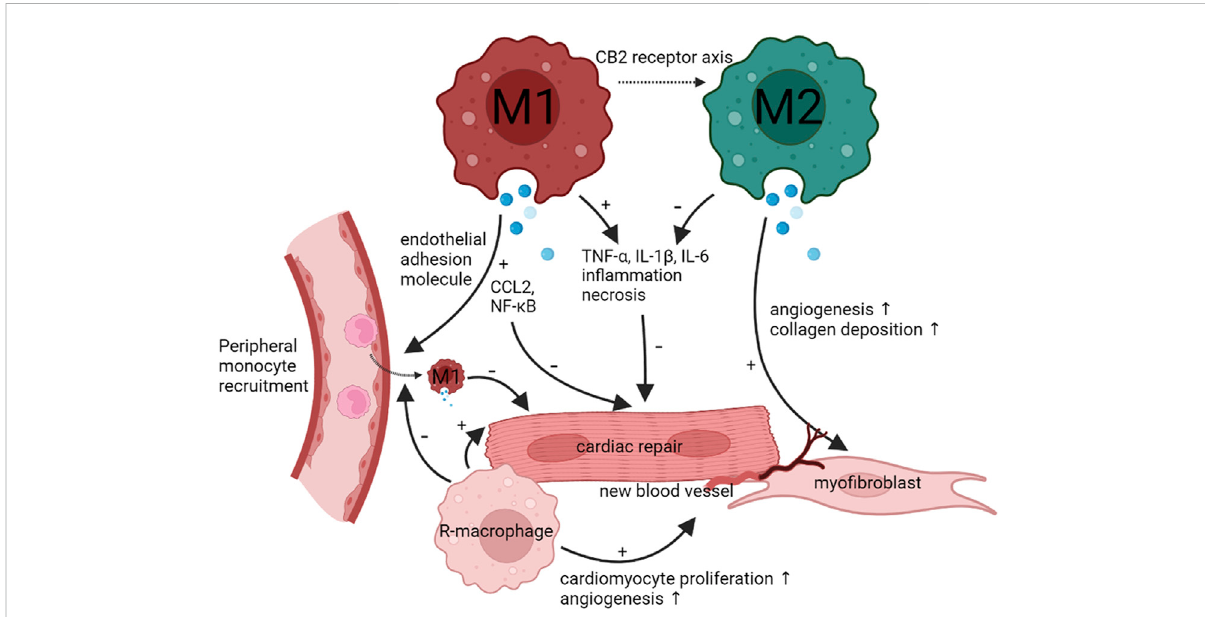
FIGURE 2 Functions and phenotype of macrophages during infection andtissue repair.When cardiomyocytes undergo injury, theheartrecruit peripheral monocyte to differentiate M1 macrophages. M1 macrophages will activate CCL2 and NF- κ B and promote TNF- α , IL-1 β , and IL-6 to inhibit cardiac repair and aggravate cardiomyocytes necrosis. As time goes on, M1 macrophages can transform M2 macrophages through CB2 receptor axis. M2 macrophages can inhibit TNF- α , IL-1 β , and IL-6 to promote cardiac repair. Meanwhile, M2 macrophages can promote angiogenesis and fi broblast formation. Cardiac resident-macrophages have the same effect as M2